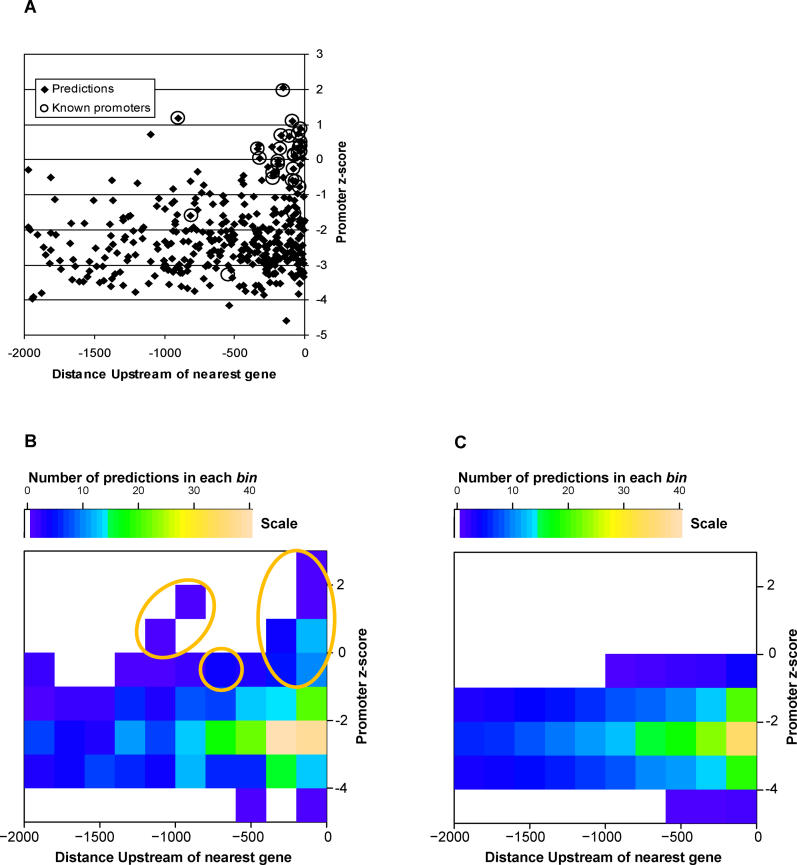
σE Promoter z-Scores versus Distance Upstream of the Nearest Gene in Actual and Randomized E. coli K-12 GenomesOnly promoters less than 2,000 nt upstream of target genes are shown.(A) Scatter plot of predicted (diamonds) and known (circles) σE promoters in E. coli K-12 MG1655.(B) Topographic plot of predicted σE promoters in E. coli K-12 MG1655. The x and y axes are divided up into 200-nt and 1 unit bins, respectively, and the number of predictions falling within each bin are indicated colorimetrically as shown in the scale. Note that the data in this plot are the same as the predictions in (A). Bins containing significant predictions are indicated by yellow ovals.(C) Topographic plot indicating average number of predicted σE promoters made from 100 randomized E. coli K-12 MG1655 genomes in silico (see Materials and Methods). Each bin illustrates the average number of predictions made from 100 separate randomized genomes that fall within the parameters of that bin.